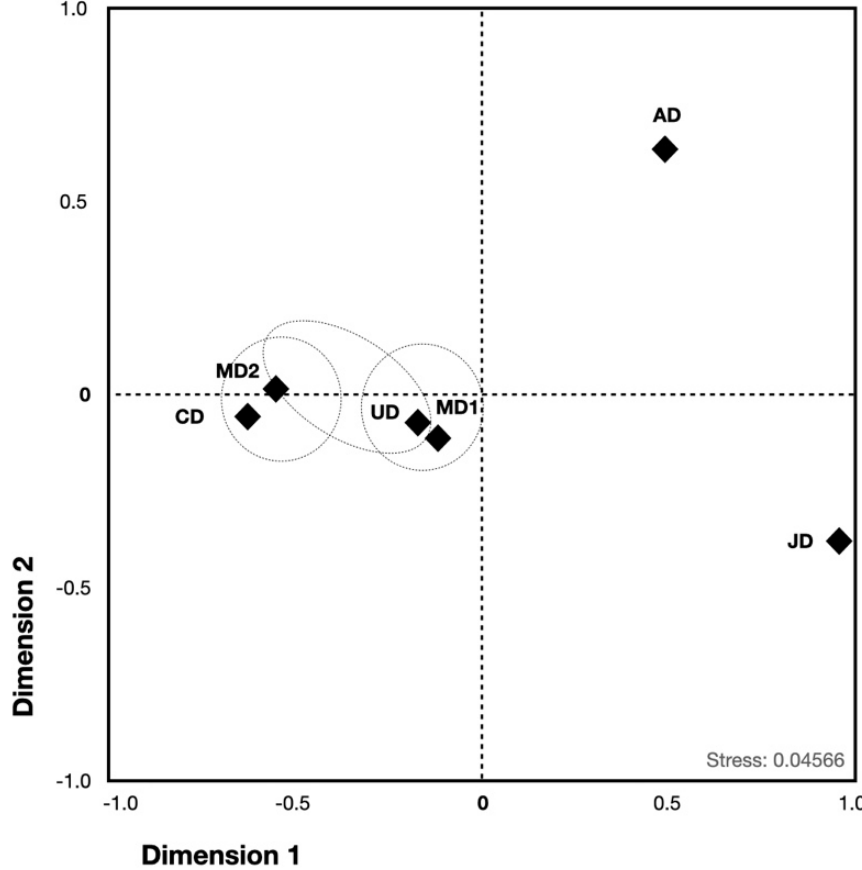
Figure 2. MDS plot of R ST values estimated from 15 STRs, including four T. truncatus geographic populations and one population with unknown geography. Diamonds represent the position of each putative population in agreement with the genetic distance whereas the dotted circle encloses those populations that share no significant genetic distances. Note: AD: Australian dolphins; CD: Cuban dolphins; JD: Japanese dolphins; MD: Mexican dolphins; UD: Unknown dolphins.